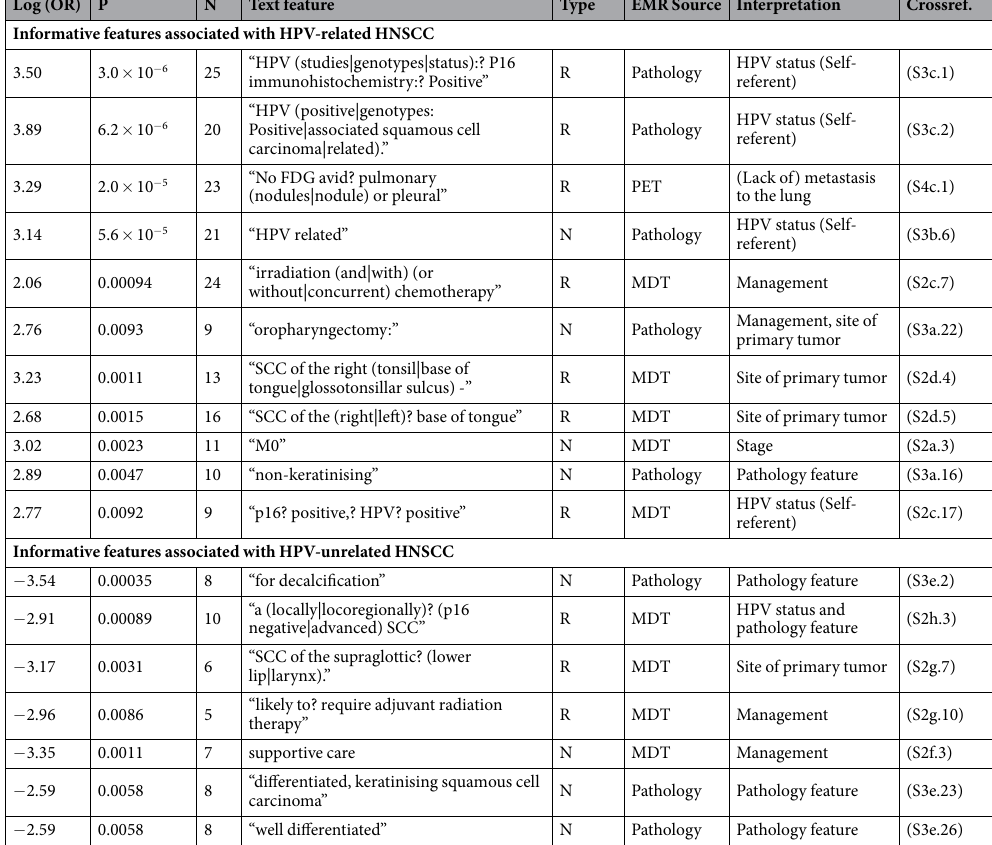
Table 2. Informative features associated with HNSCC by HPV status as discovered by TEPAPA. Note: The type field indicates the type of text features (N: n-gram fragments or R: regular expression). N indicates number